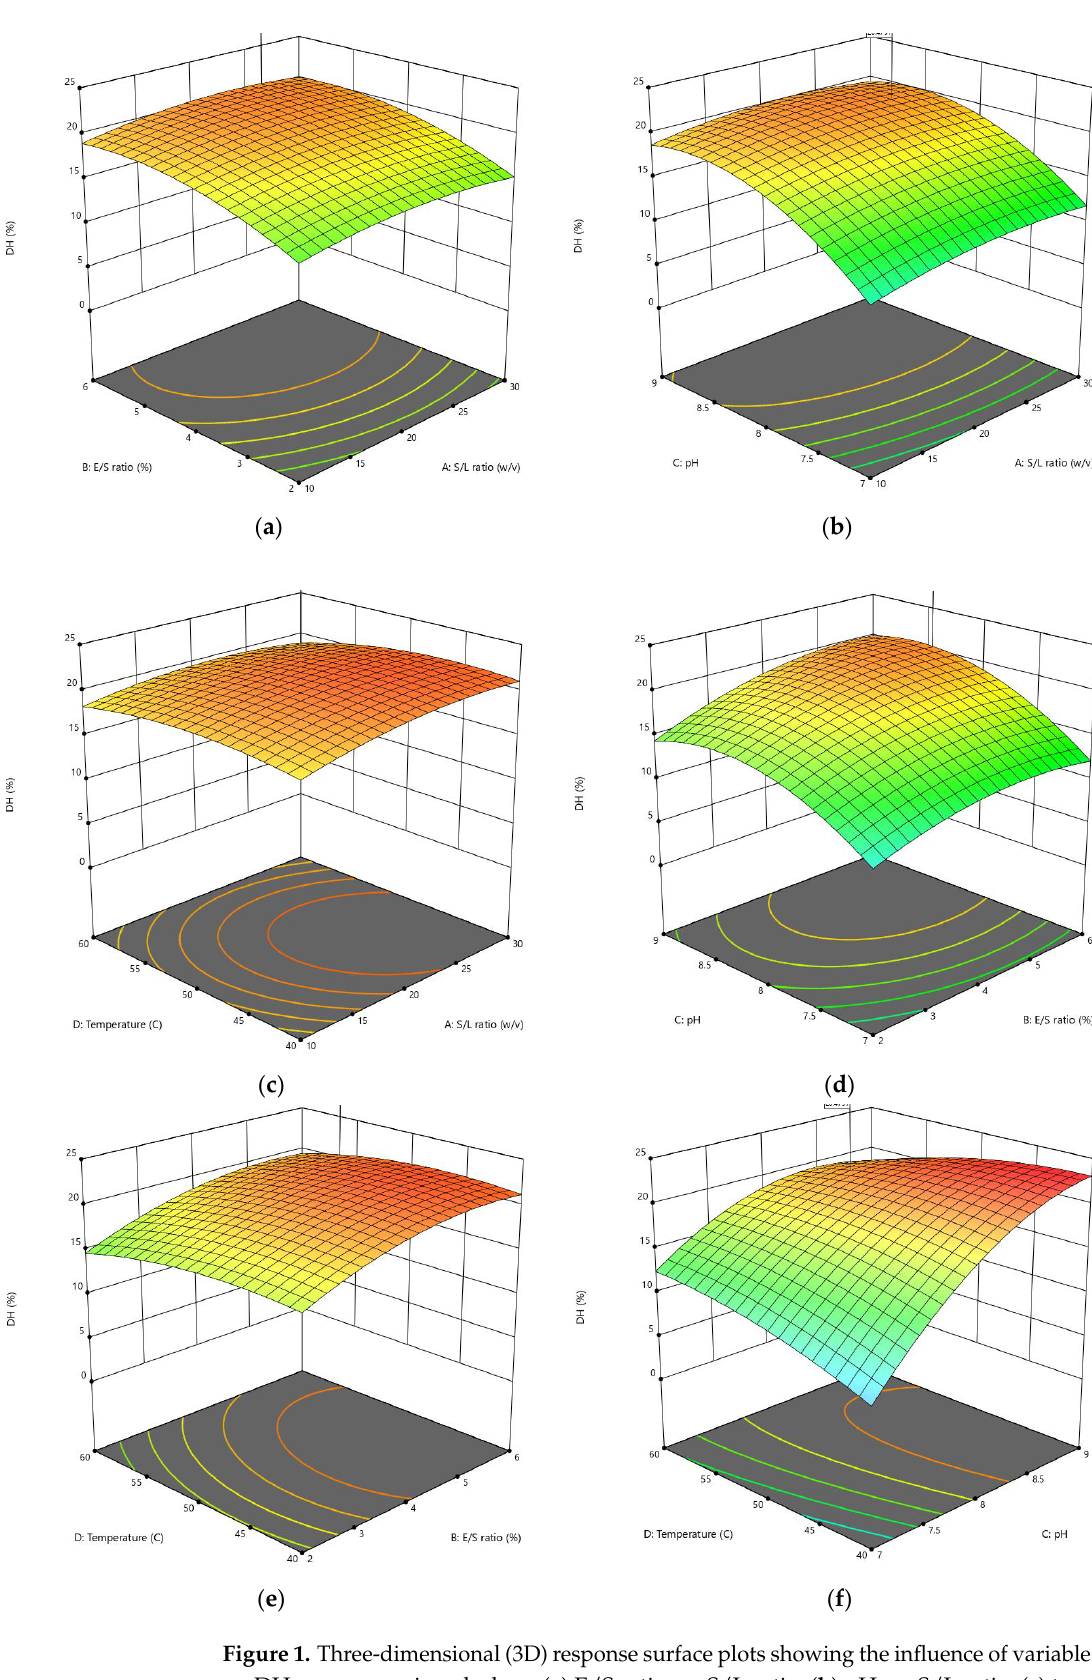
Figure 1. Three-dimensional (3D) response surface plots showing the influence of variable parameters on DH response using alcalase: ( a ) E/S ratio vs. S/L ratio, ( b ) pH vs. S/L ratio, ( c ) temperature vs. S/L ratio, ( d ) pH vs. E/S ratio, ( e ) temperature vs. S/L ratio and ( f ) temperature vs. pH.